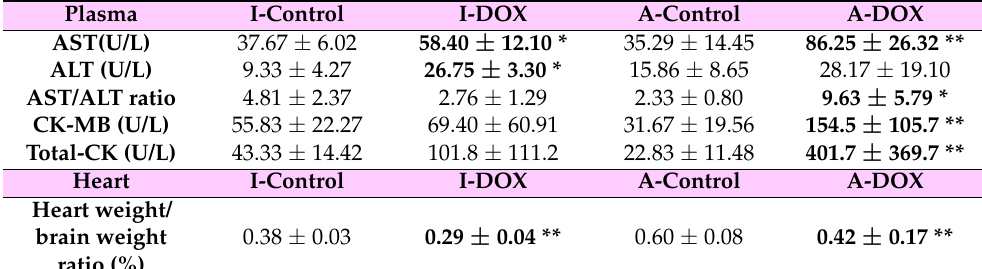
Table 1. Plasma biomarkers and heart weight-to-brain weight ratio after DOX (18.0 mg/kg cumula- tive